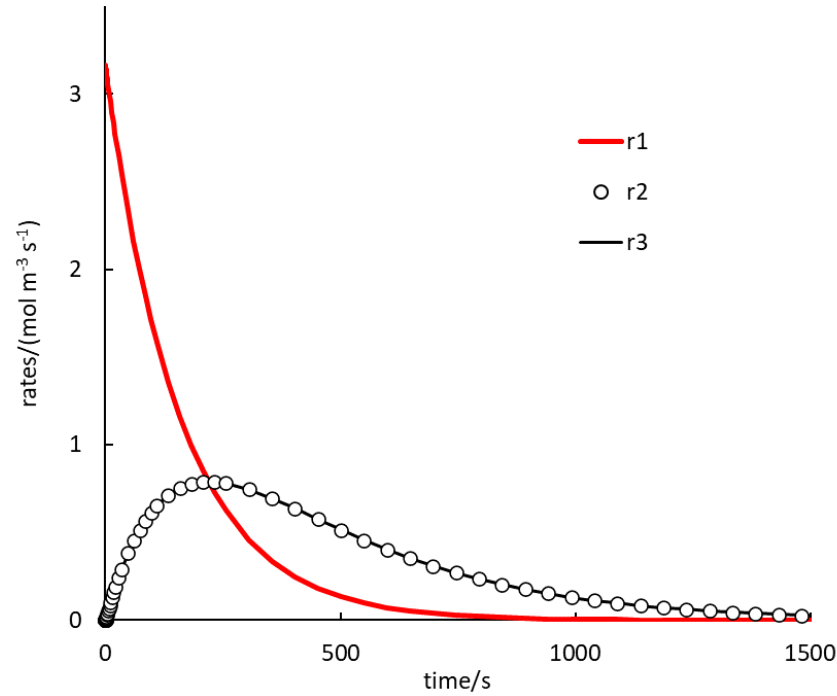
Figure 2. Modeled rate time profiles. Reaction scheme (R1), rates (1), batch system. Rate constants correspond to the cyan curve in Figure 1 in [14]: k 1 = k 2 = 3.1623×10 −8 , k 3 = 10 4 (all m 3 mol −1 s −1 ).